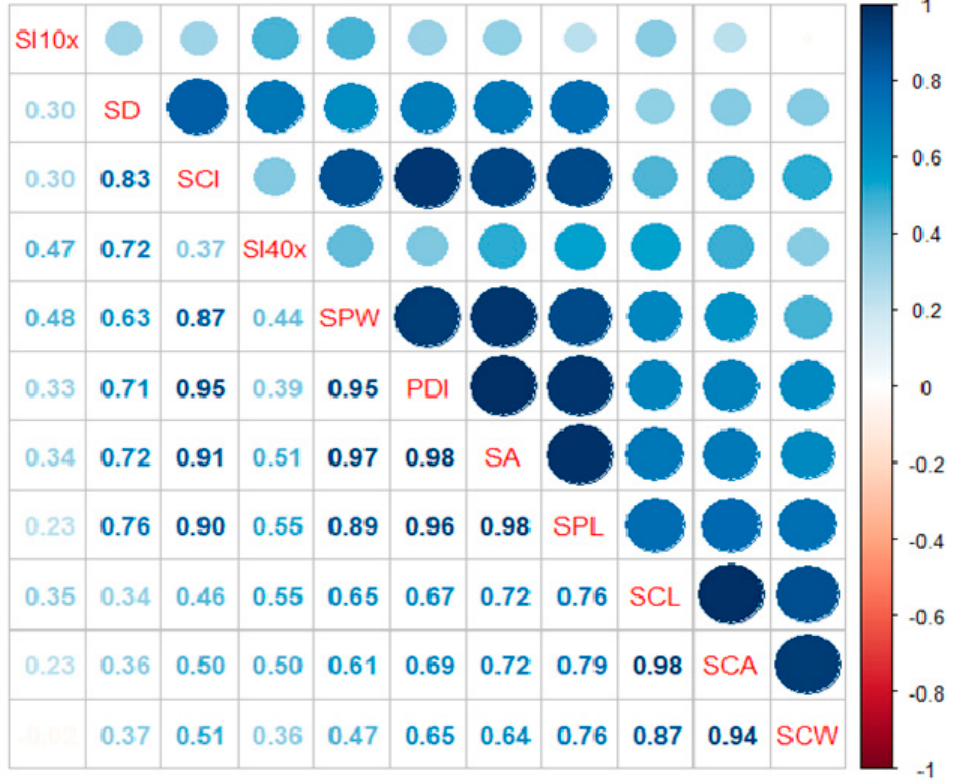
Figure 3. Correlation of percentage disease index (PDI) with stomatal parameters in different Citrus spp. where PDI: Percentage of disease index, SPL: Stomata pore length, SPW: Stomata pore width, SCL: Stomata complex length, SCW: Stomata complex width, SA: Stomata area, SCA: Stomata complex area, SD: Stomatal density, SI: Stomatal index, SCI: Stomatal conductance index.